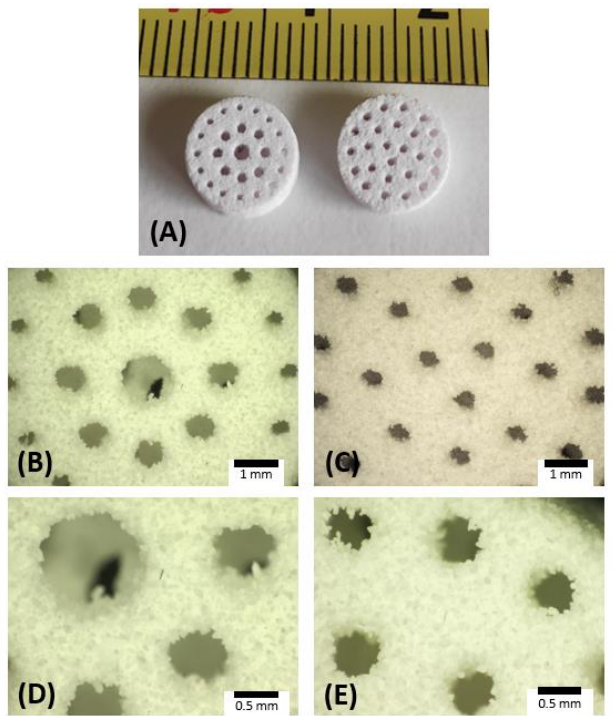
Figure 5. FTIR spectra of CB-CaP ( a ) and AP40mod ( b ) powders.